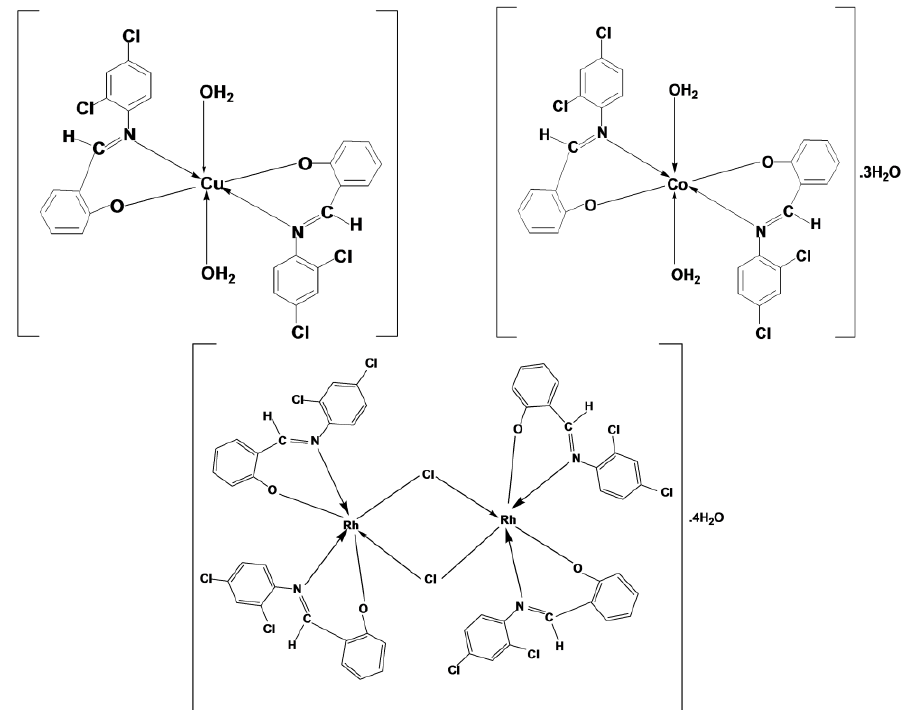
Figure 1. Expected structures of Cu(II), Co(II), and Rh(III)